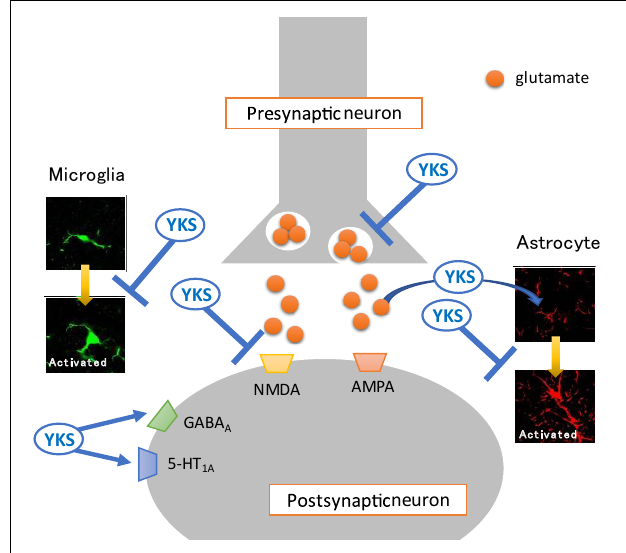
FIGURE 1 | Mechanisms of action of Yokukansan for neuropathic pain. Several different mechanisms of action may act on neurotransmission in the spinal dorsal horn. (1) Attenuation of excessive glutamate release from presynaptic neurons. (2) Promotion of the uptake of glutamate into astrocytes. (3) Antagonistic effect on the glutamate receptor, N -methyl- D -aspartate (NMDA) receptor. (4) Agonistic effect on the GABA A receptor. (5) Inhibition of the activation of glia cells (microglia and astrocyte). (6) Agonistic effect on the serotonin 5-HT 1A receptor. YKS, Yokukansan; AMPA, α -amino-3-hydroxy-5-methyl-4-isoxazolepropionic acid